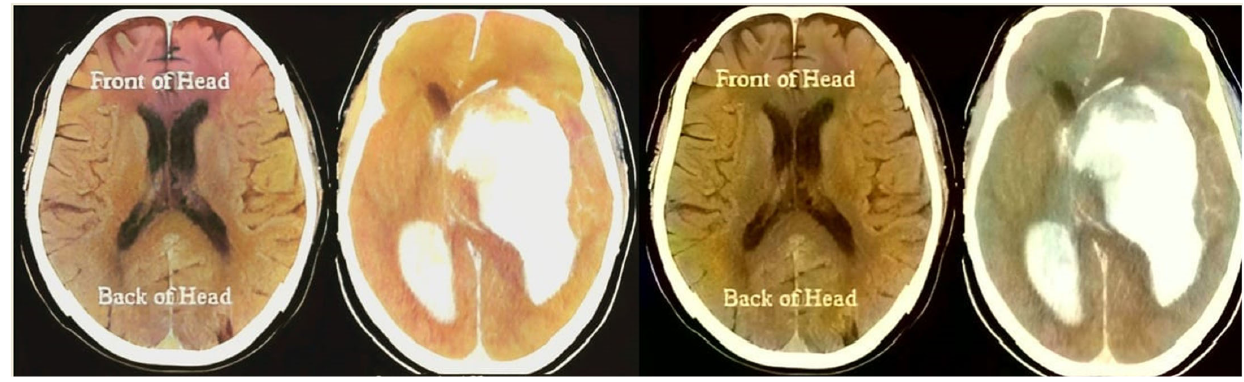
Figure 5. Histograms of original and compressed images.